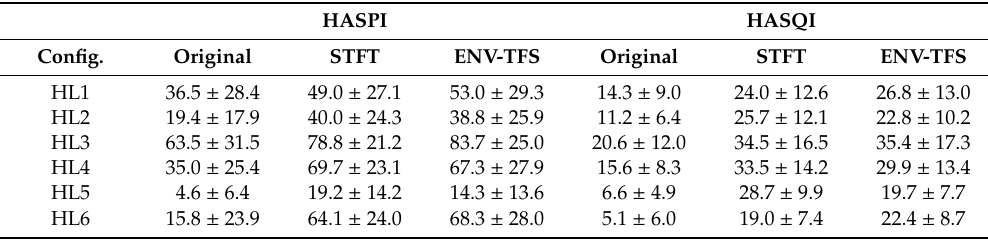
Table 3. Objective speech perception (HASPI) and quality (HASQI) results (mean ± standard deviation in percentage) for six typical hearing loss audiograms between the STFT and the ENV-TFS systems, compared to the original noisy speech